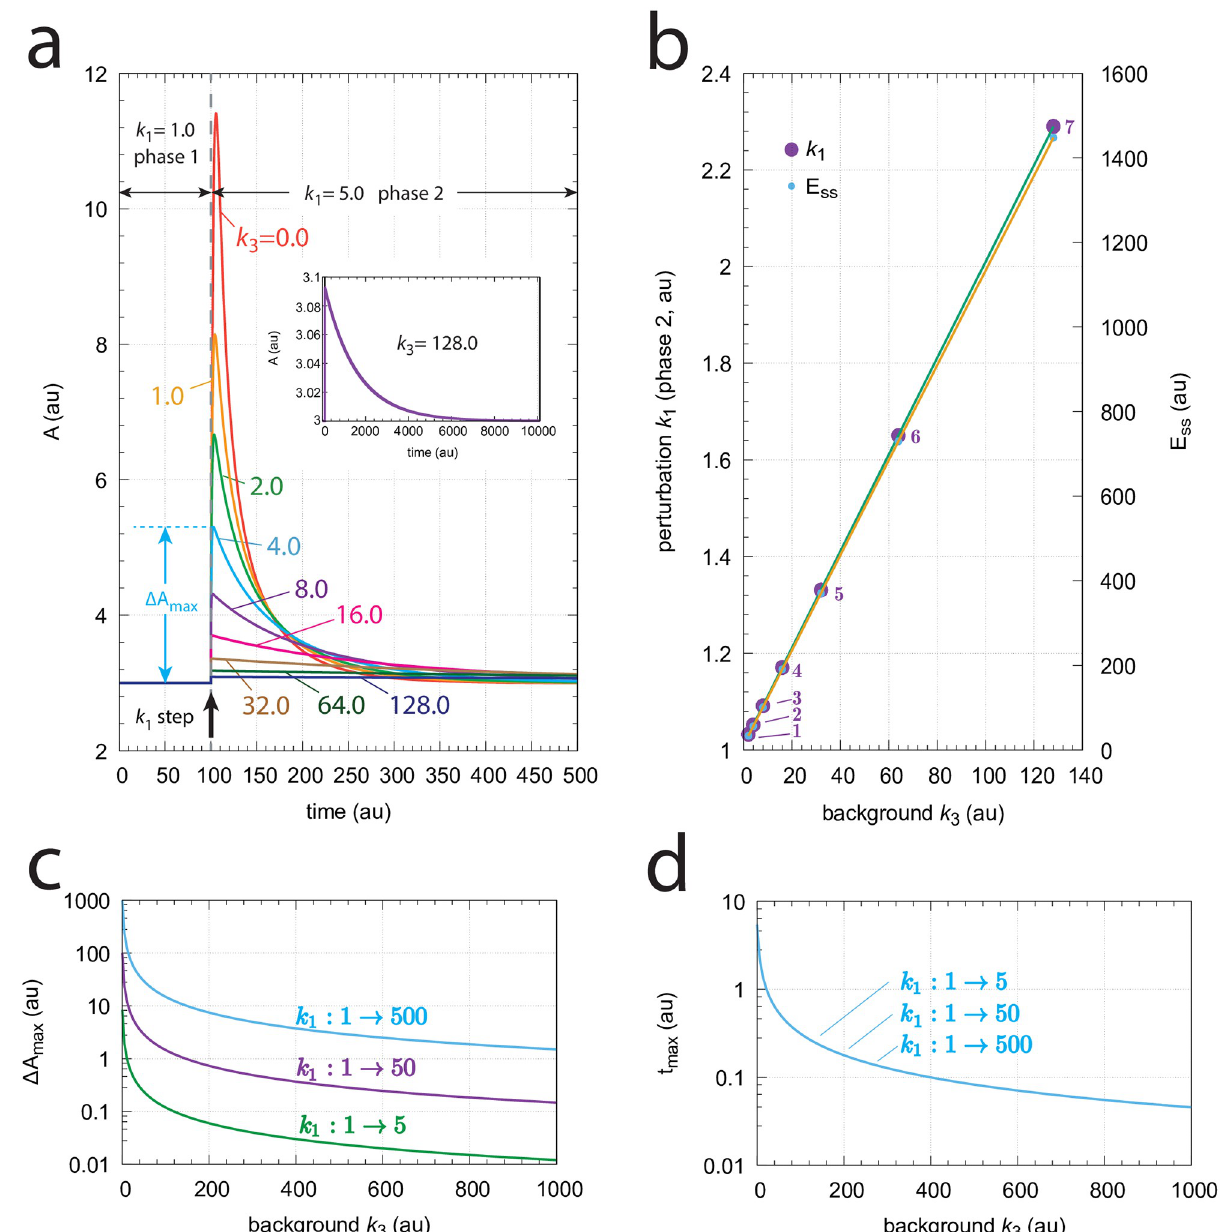
Fig 6. Response kinetics and relationship to Weber’s law in the m7 controller (Fig 5). The set-point of A is 3.0. (a) Step-wise increase of k 1 from 1.0 to 5.0 at time t =100 at different and constant background perturbations k 3 (0–128.0, applied in phases 1 and 2). Note the successive decrease in the maximum excursion of A ( Δ A max ) with slowed-down A resetting kinetics as k 3 values increase. Δ A max for k 3 =4.0 is indicated. Rate constants (in au): k 1 =1.0, k 2 =0.0 (phases 1 and 2), k 1 =5.0 (phase 2), k 3 variable, k 4 =0.03, k 5 =1.0, k 6 =31.0, k 7 =1 × 10 − 6 , k 8 =0.1. Initial concentrations (in au): A 0 =3.0, E 0 =11.11 ( k 3 =0); A 0 =3.0, E 0 =22.22 ( k 3 =1); A 0 =3.0, E 0 =33.33 ( k 3 =2); A 0 =3.0, E 0 =55.55 ( k 3 =4); A 0 =3.0, E 0 =100.0 ( k 3 =8); A 0 =3.0, E 0 =188.89 ( k 3 =16); A 0 =3.0, E 0 =366.67 ( k 3 =32); A 0 =3.0, E 0 =722.22 ( k 3 =64); A 0 =3.0, E 0 =1433.33 ( k 3 =128). The inset shows the full adaptation response when k 3 =128.0 (b) Relationship to Weber’s law: When perturbation k 1 in phase 2 is adjusted such that the maximum (just noticeable) excursion Δ A is 0.03 (i.e. 1% of max A set ) then both k 1 and the “perception” E ss are linear functions of the background k 3 . Rate constants and initial concentrations as in (a), except that k 1 in phase 2 has the following values: 1 , k 1 = 1.0325 ( k 3 = 2); 2 , k 1 = 1.0520 ( k 3 = 4); 3 , k 1 = 1.0914 ( k 3 = 8); 4 , k 1 = 1.1709 ( k 3 = 16); 5 , k 1 = 1.3306 ( k 3 = 32); 6 , k 1 = 1.6503 ( k 3 = 64); 7 , k 1 = 2.2900 ( k 3 = 128). (c) Δ A max values as a function of background k 3 for three step perturbations in k 1 . Note that the three curves are congruent, i.e., their identical shape can be precisely moved onto each other. (d) t as a function of background k 3 . For a given background max t max is practically the same and independent of the three k 1